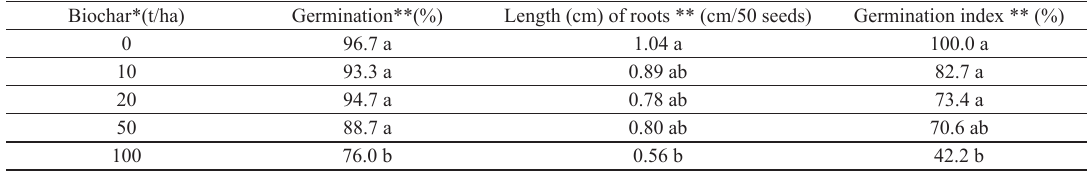
Table 2. Effect of different BSC rates on germination (%), length (cm) of roots, and germination index (%) of lettuce ( Lactuca sativa ).